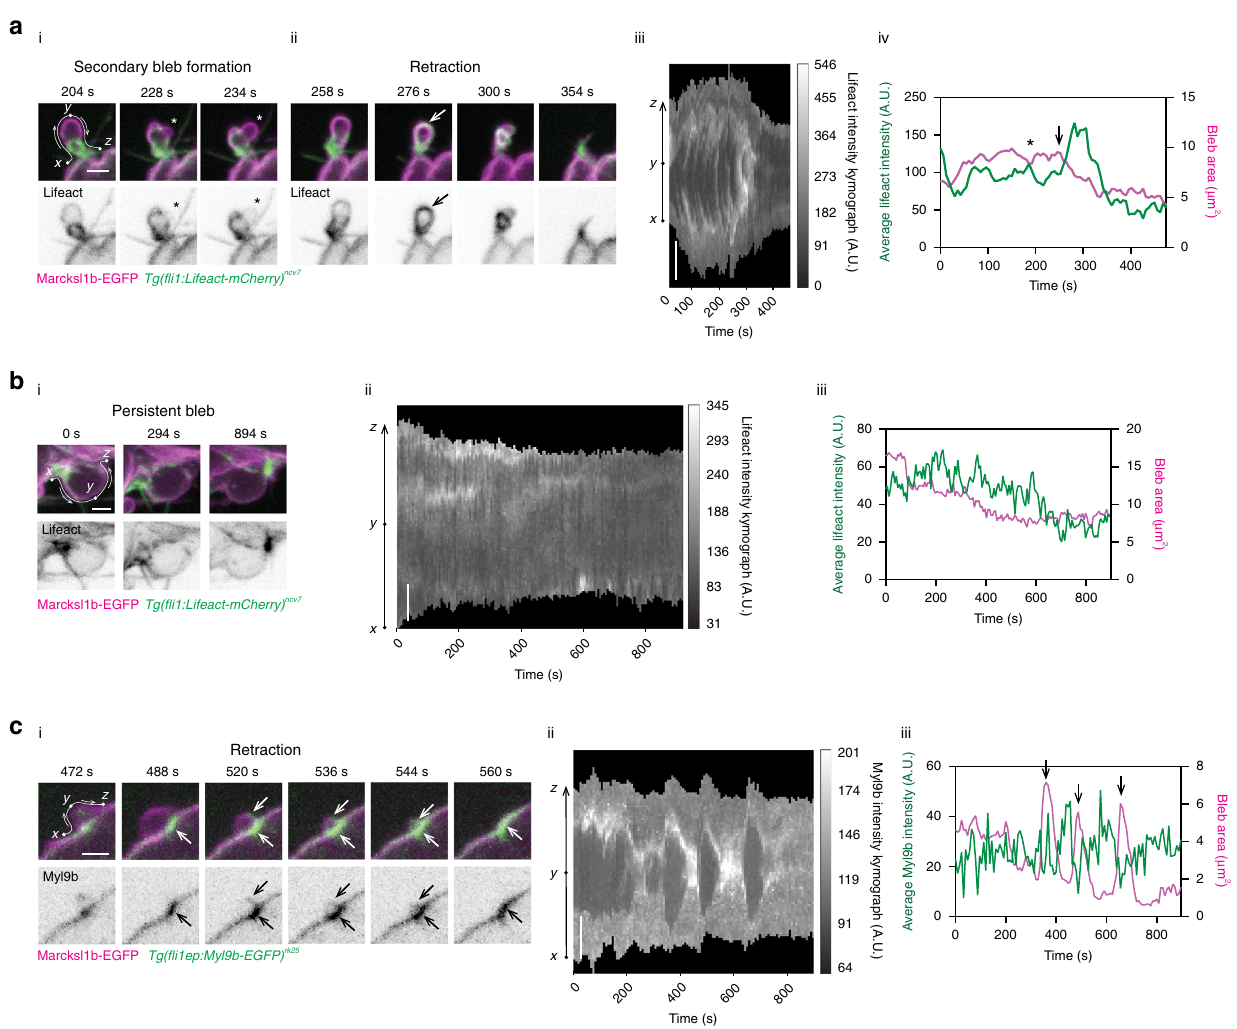
Fig. 6 Reassembly of actomyosin network at bleb cortex precedes basal bleb retraction. The spatiotemporal dynamics Lifeact (actin, a , b ; representative images of 17 embryos from 4 independent experiments; secondary bleb formation was observed in 27/100 blebs, retraction in 52/100 blebs and persistent blebs in 27/100 blebs) and Myl9b (non-muscle myosin II, c representative image of 21 retracting blebs from 5 embryos from 2 independent experiments) at the cortex of Marcksl1b-induced bleb are depicted in time-lapse images (i and ii in a , i in b , c ), kymographs (iii in a , ii in b , c ) and as an average intensity over time (iv in a , iii in b , c ). Negative correlation between actin ( a ) or non-muscle myosin II ( c ) intensity and bleb area is observed in retracting blebs while little change in actin intensity is observed in blebs that do not retract ( b ). *, secondary bleb. Arrow, increase in actin or non-muscle myosin II assembly. Scale bar, 2 µ